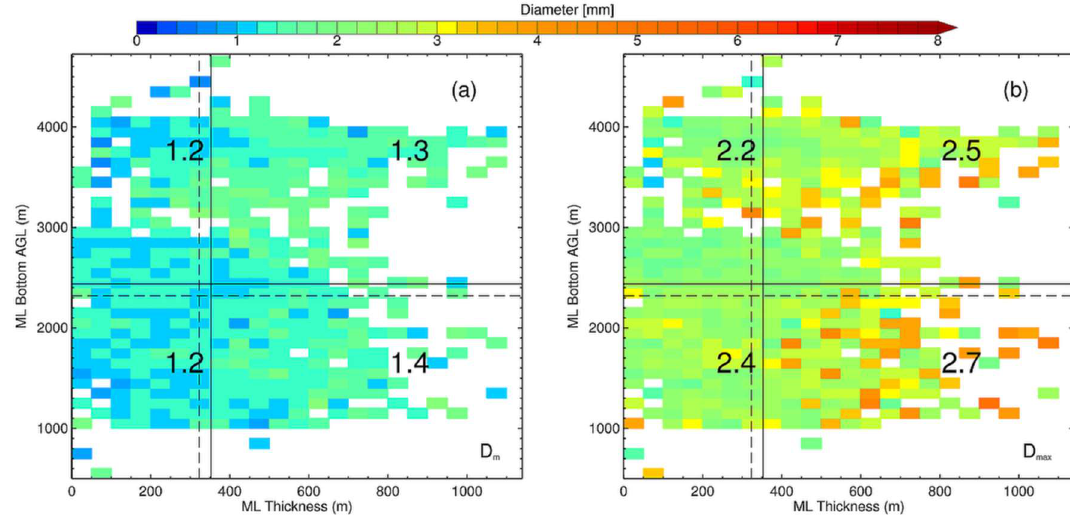
Figure 3. The ( a ) mean D m and ( b ) maximum D max at the ground from 2DVD measurements of rainfall as a function of the overlying melting layer thickness and its height above ground (i.e., ML bottom). The mean values of D m and D max (mm) inside each quadrant of the ML thickness and ML bottom space are given. The mean (median) of the ML measurements are indicated by the solid (dashed) lines.